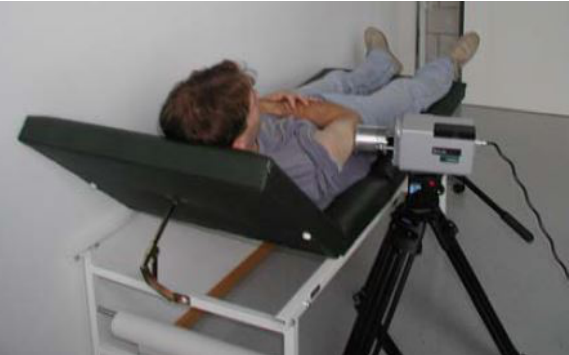
Figure 5. IR camera with macro lens placed on a tripod. Reprinted with permission from Ref. [27]. 2006, ACTA